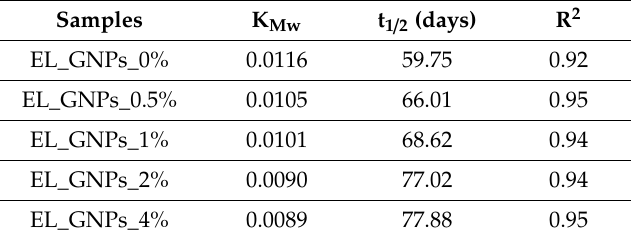
Table 3. Apparent degradation rate (K Mw ) and half degradation time (t 1 / 2 ) calculated by plotting lnM w vs. degradation time.